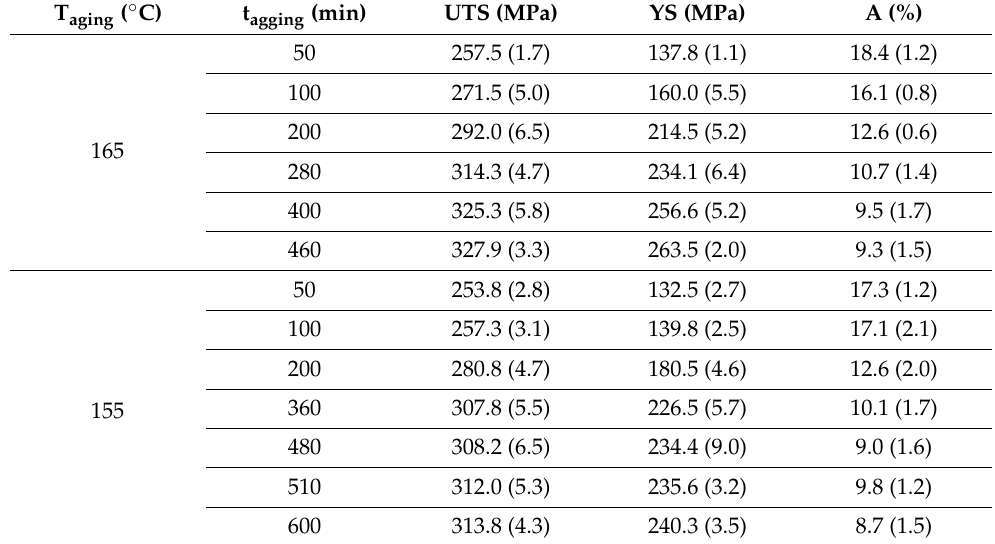
Table 10. Average values of UTS, YS and A for each aging temperature and time in castings TA (standard deviation values are shown between